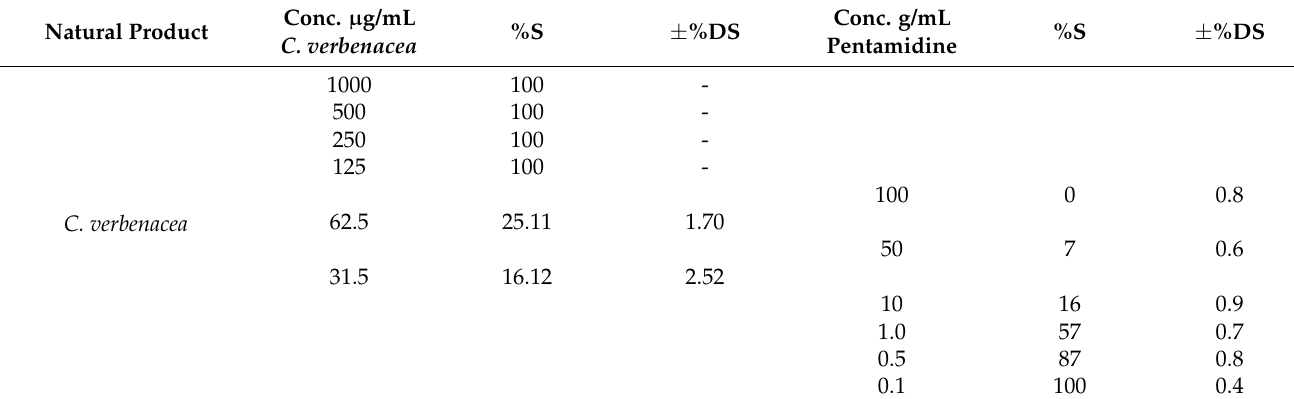
Table 4. Survival of the epimastigote T. cruzi treated with C. verbenaceae essential oil. Natural